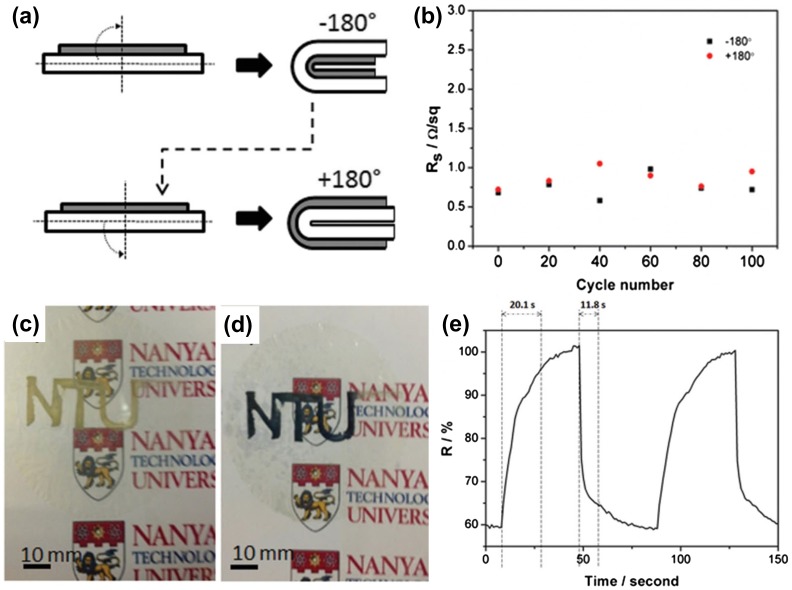
Schematics for the folding procedure. (b) Sheet resistance versus the number of ±180° folding cycles. Images of the EC nanopaper in the (c) bleached state and (d) colored state. (e) Switching rate test [41]. Reproduced with the permission of [41]. Copyright 2015 Wiley-VCH.